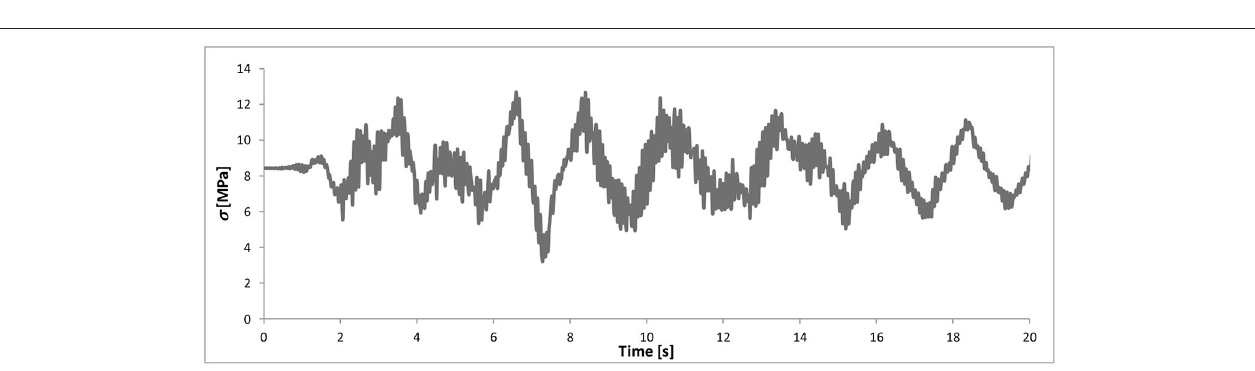
FIGURE 8 | Time history of the axial force (in terms of stress) of device #1, used for computing the device response to variable axial force depicted in Figure 10 .